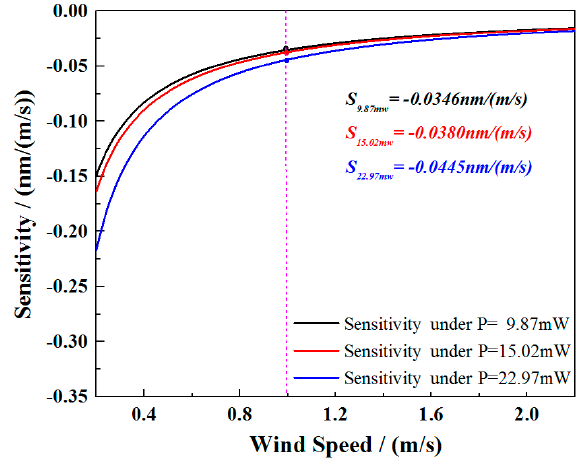
Figure 11. Sensitivity as a function of wind speed under different input power.